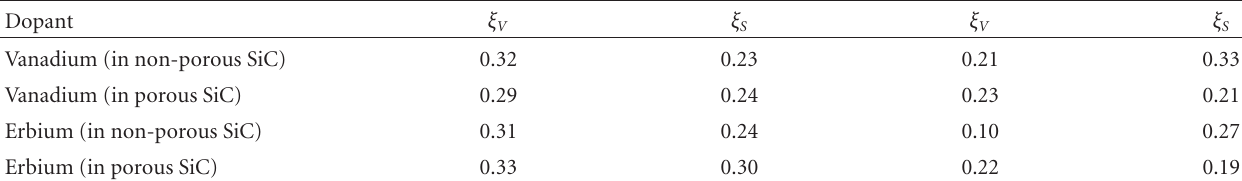
Table 2: Fitting parameters for Figure